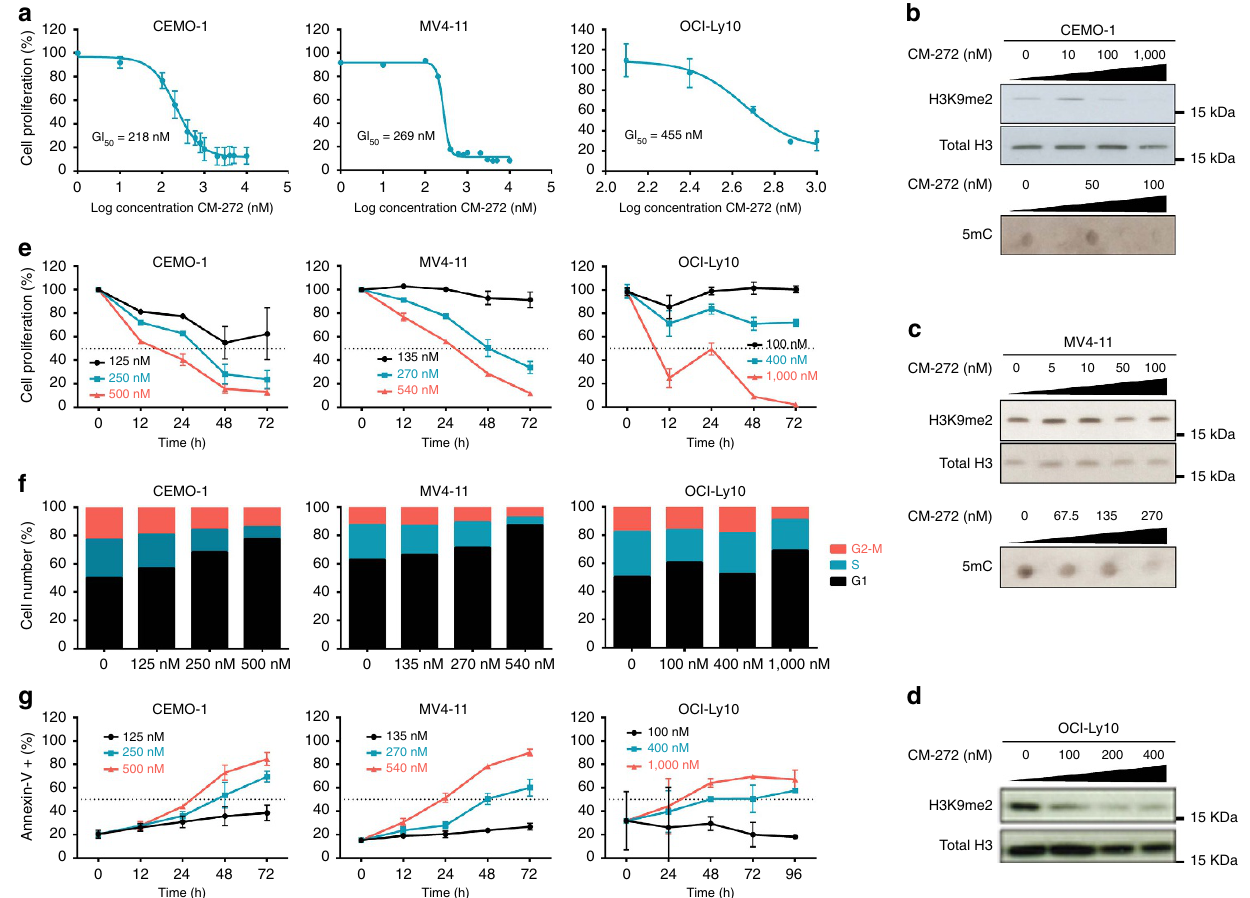
Figure 2 | CM-272 inhibits cell proliferation and induces apoptosis. ( a ) GI 50 values of CM-272 for CEMO-1 ALL cell line, MV4-11 AML cell line and OCI- Ly10 DLBCL cell line. ( b ) H3K9me2 and 5mC levels after CM-272 treatment with different doses for 48h in CEMO-1 cell line. H3 total was used as loading control. ( c ) H3K9me2 and 5mC levels after CM-272 treatment with different doses for 48h in MV4-11 cell line. H3 total was used as loading